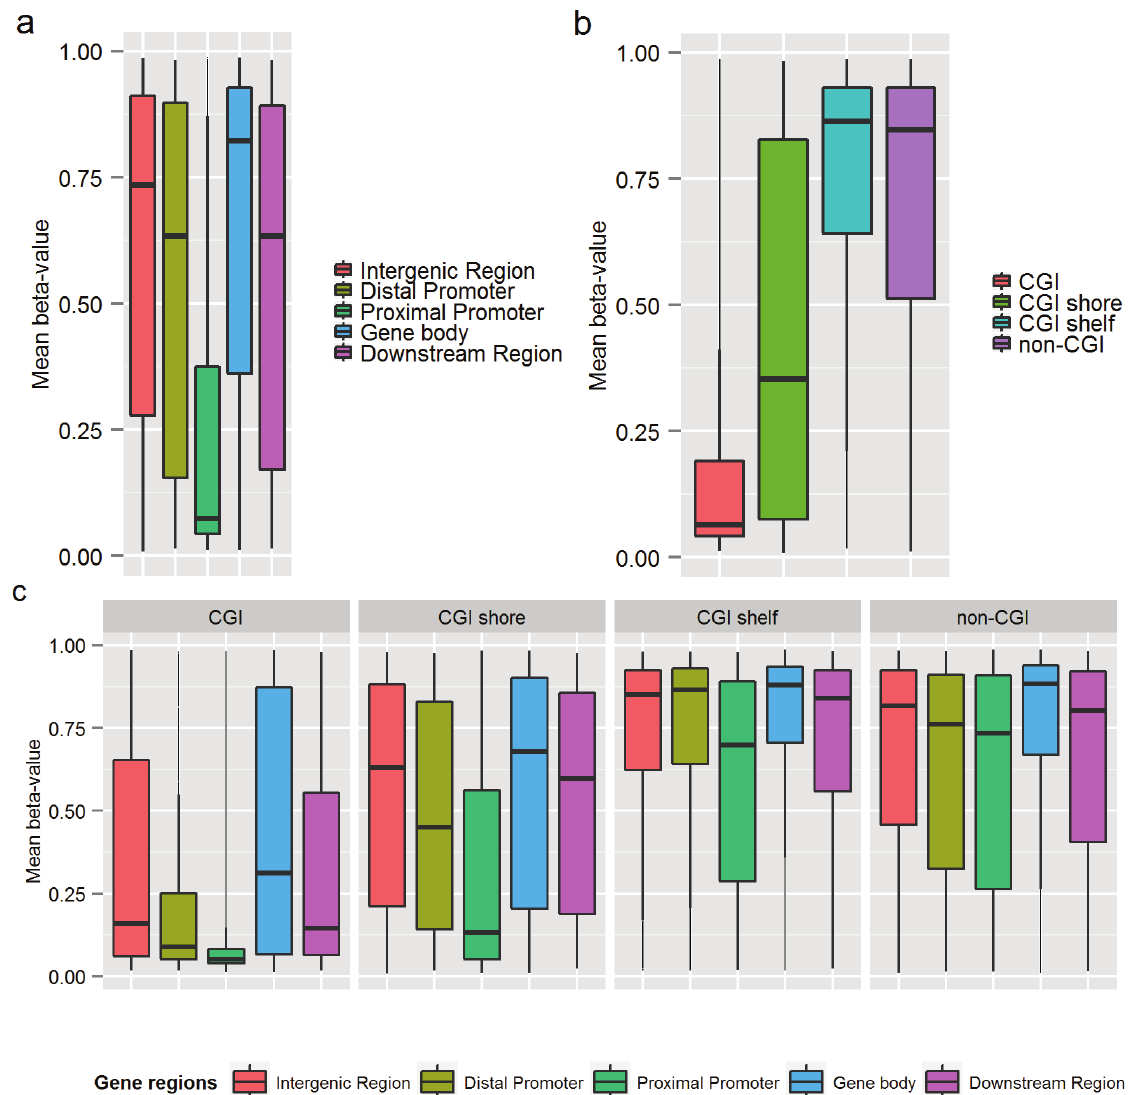
Figure 3. Average methylation level of individual CpGs across gene regions ( a ), CpG islands (CGI) and non-CGI regions ( b ) and for each genomic feature separately ( c